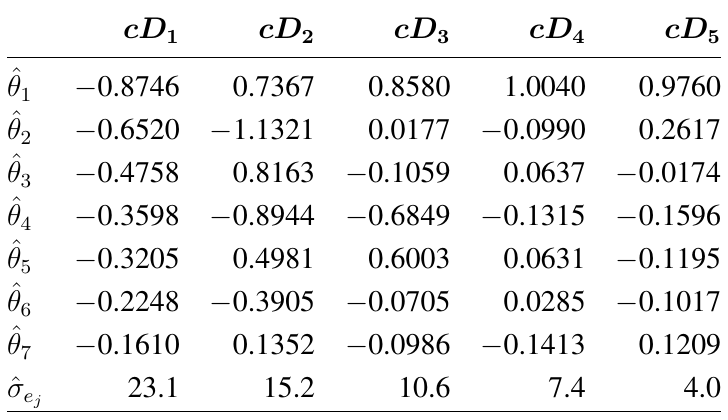
Table 1. Estimated coefficients and standard deviation of forecast errors for scale-level AR(7) models, based on the first 184 days.